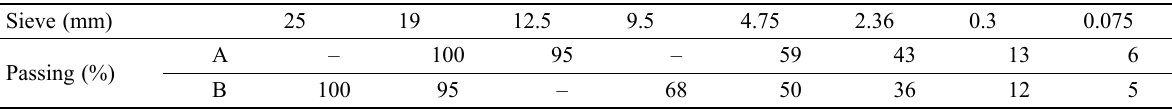
Table 2. Gradation of aggregates used in the present study Sieve